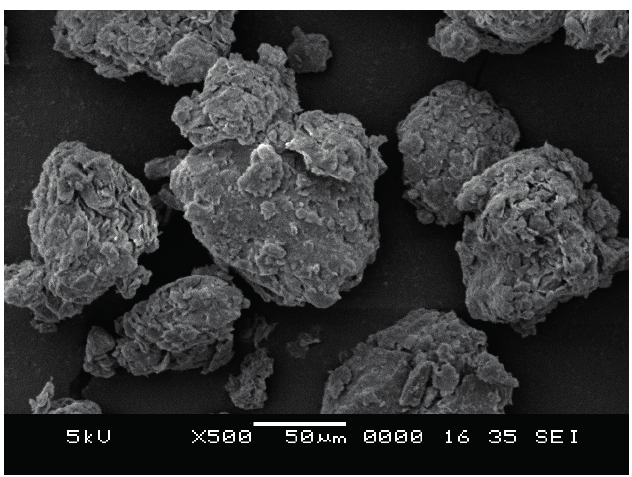
Figure 12. SEM images of original LUSI mud.